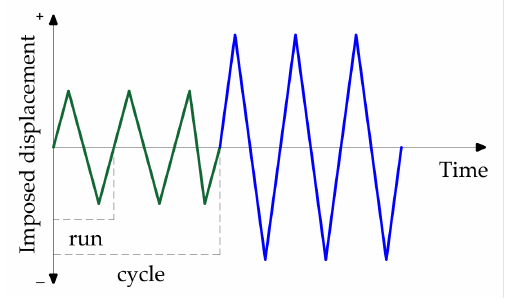
Figure 8. Cyclic loading